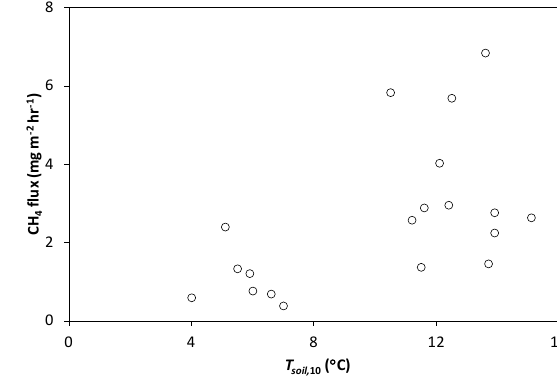
) Figure 6. Methane (CH ) flux vs soil temperature T 4 at 10 cm depth for one of the collars at the North Wales blanket peatland site.